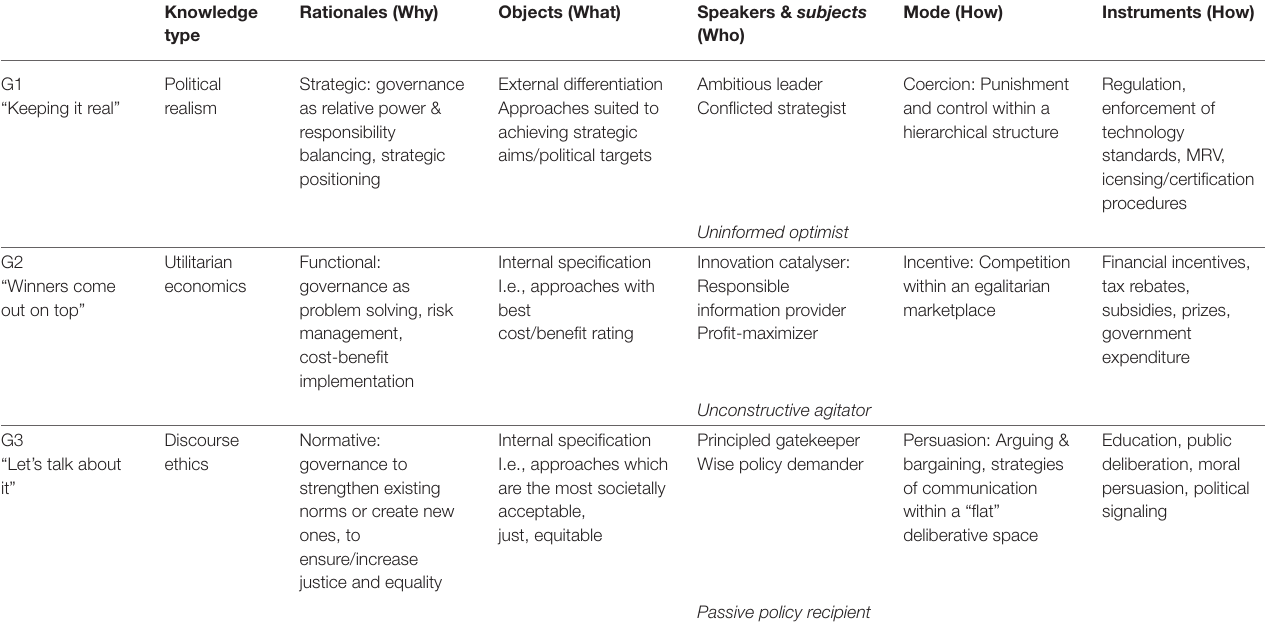
TABLE 1 | Discusive “blueprints” for emergent NETs governmentalties in the UK industry/policy sphere.